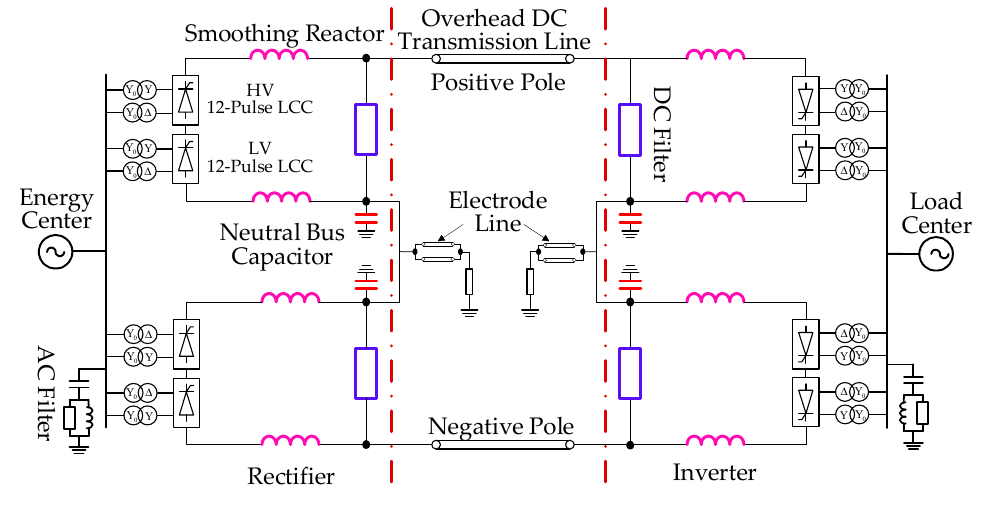
Figure 1. Structure of the LCC-HVDC system.